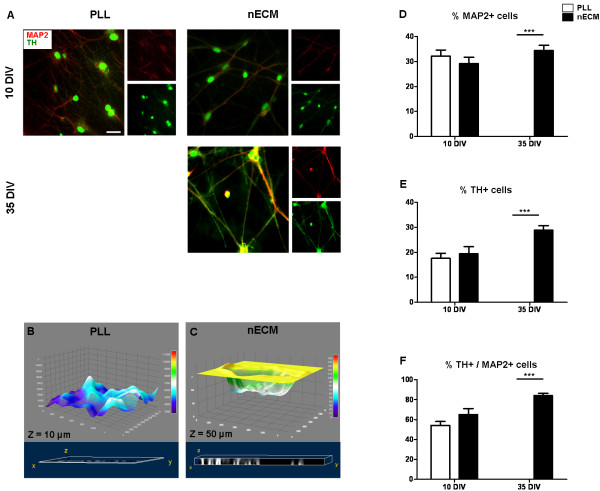
Dopaminergic differentiation of SVZ-derived progenitors on PLL- and nECM-coated coverslips. (A) SVZ-derived neurospheres were seeded both on PLL- and nECM-coated coverslips and differentiated in the presence of a dopaminergic medium (including NGFβ, BDNF, Shh and FGF8b) for 10 or 35 days, respectively. Double stainings were performed with anti-MAP2 (red) and anti-TH (green) antibodies and nuclei counterstained with Hoechst (not shown). Colocalization of both markers is shown in the Merged (large) panels. All images are representative of three independent experiments. Scale bar, 40 μm. (B-C) Z stack analysis of cells differentiated for 10 days in PLL (B) or nECM (C). Upper panels (grey) show cell profiles, demonstrating cell incorporation into the matrix; lower panels (blue) show stack as a volume with Z value as 10 μm in PLL or 50 μm in nECM (see also Additional file 1 Video S1 and Additional file 2 Video S2). (D-F) To estimate the percentage of MAP2 and TH positive cells in each substrate and time condition, MAP2 (D) and TH (E) positive cells were determined. To obtain the ratio of TH positive neurons (F), TH positive cell number was divided by the MAP2 positive cell number. At least six different fields out of three independent experiments were quantified in each medium, substrate and time point. Statistical analyses were done by using two-way ANOVA assay followed by Bonferroni’s posttests (*P < 0.05; ** P < 0.01; *** P < 0.001).